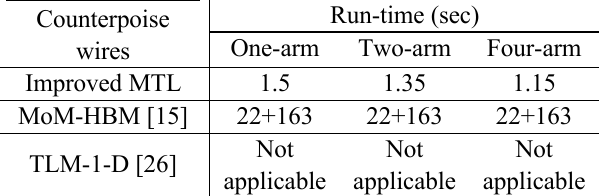
Table 4: Comparing run-times of the three different methods for computing transient voltage of the counterpoise wires buried in both-affected soils